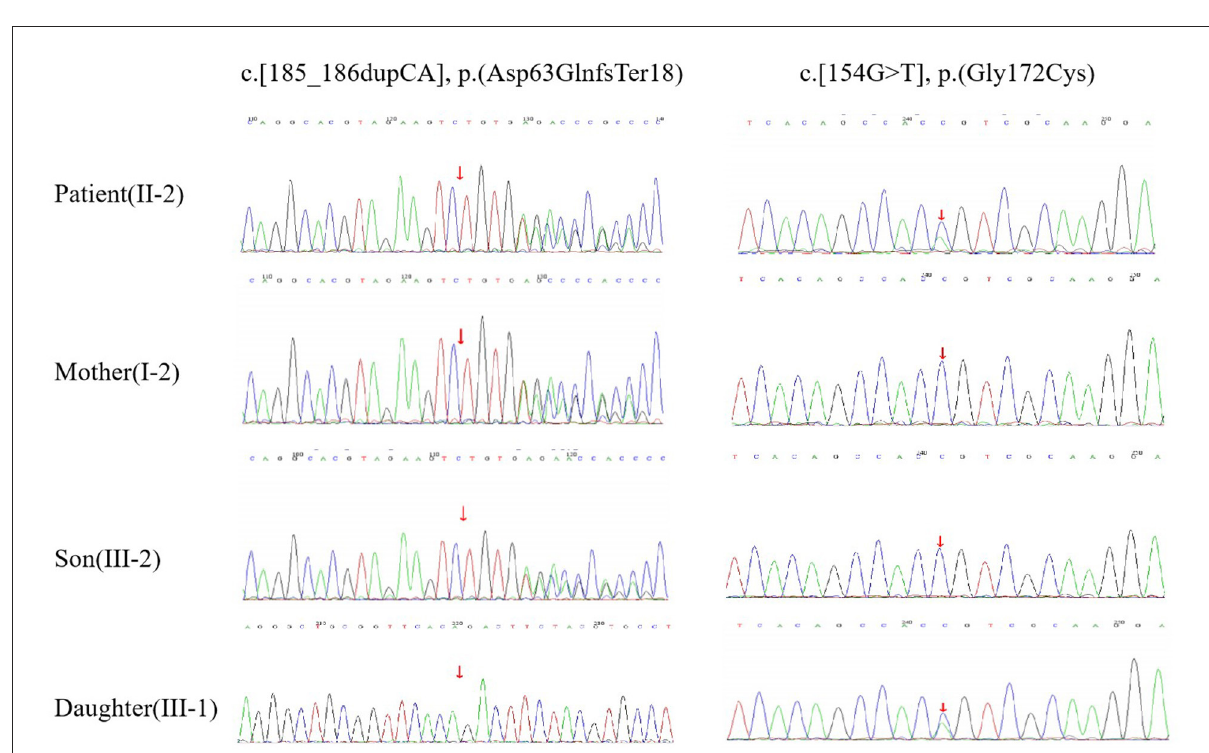
FIGURE2 DNA sequencing. The patient (II-2) had compound heterozygous mutations of c.[185_186dupCA], p.(Asp63GlnfsTer18) and c.[154G>T], p.(Gly172Cys) in the ARSA gene. Her mother (I-2) and son (III-2) had the heterozygous mutation of c.[185_186dupCA], p.(Asp63GlnfsTer18). Her daughter (III-1) had the heterozygous mutation of c.154G > T,